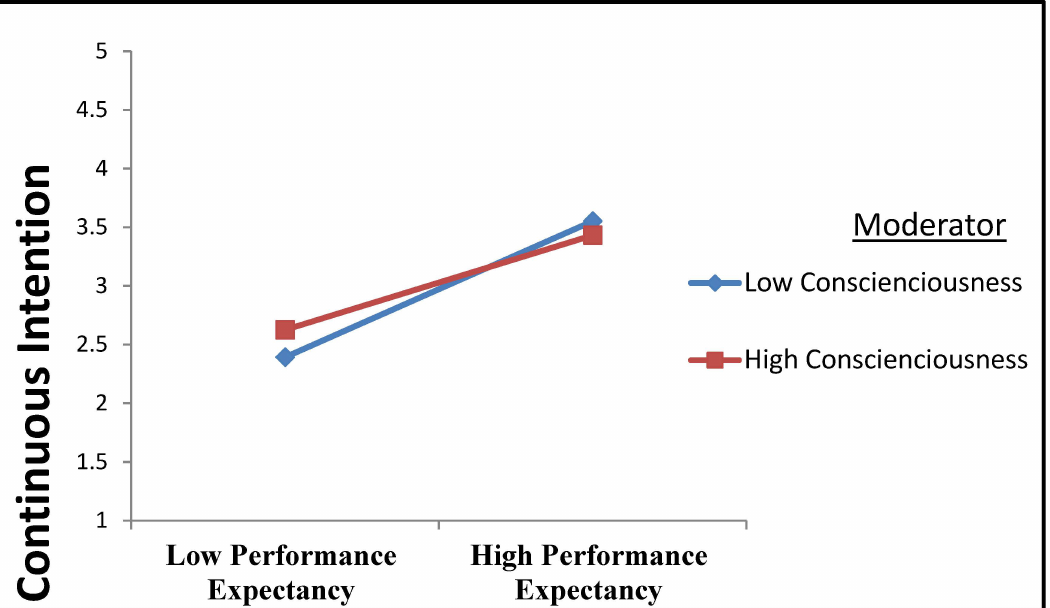
Figure 2. Conscientiousness Dampens the Positive Relationship between Performance Expectancy and Continuous